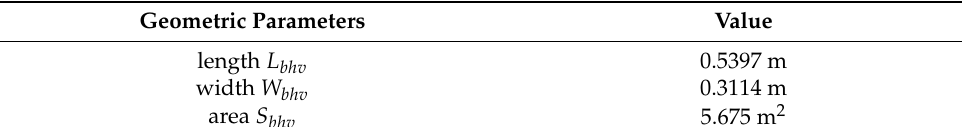
Table 1. Geometric parameters of BHV model.